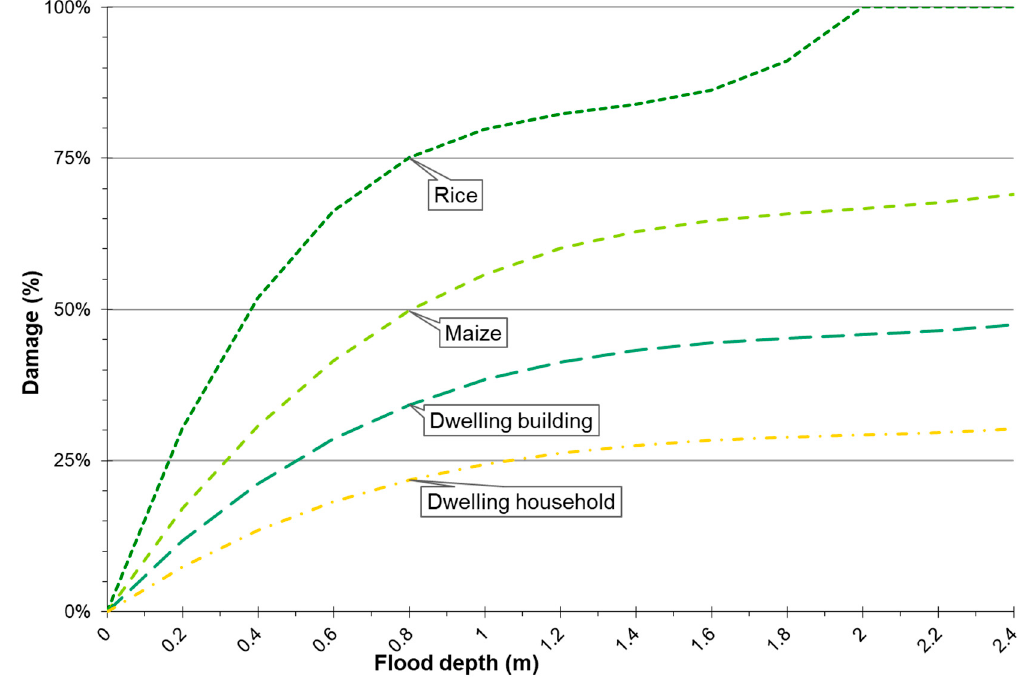
Figure 6. Stage–damage functions adapted from local authorities, Chen (1999), Wang and Xiang, and the ANFAS project [89–91].